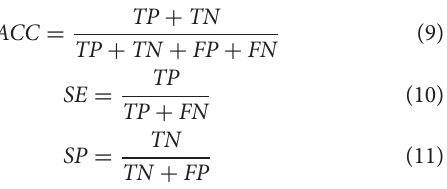
TABLE 2 | Ablation study for pre-processing strategy on CCA dataset.